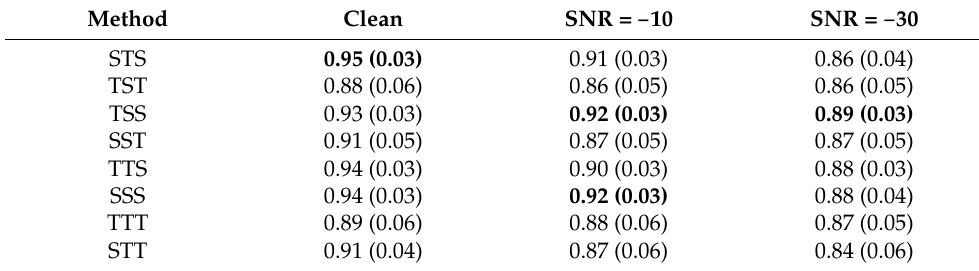
Table 9. Average AUCs (and standard deviations) for all possible choices of group actions (S for SL n and T for T n ) on PTB tensors. For example, STS stands for SL 6 × T 5 × SL 12 . The bold values represent the best performance for each